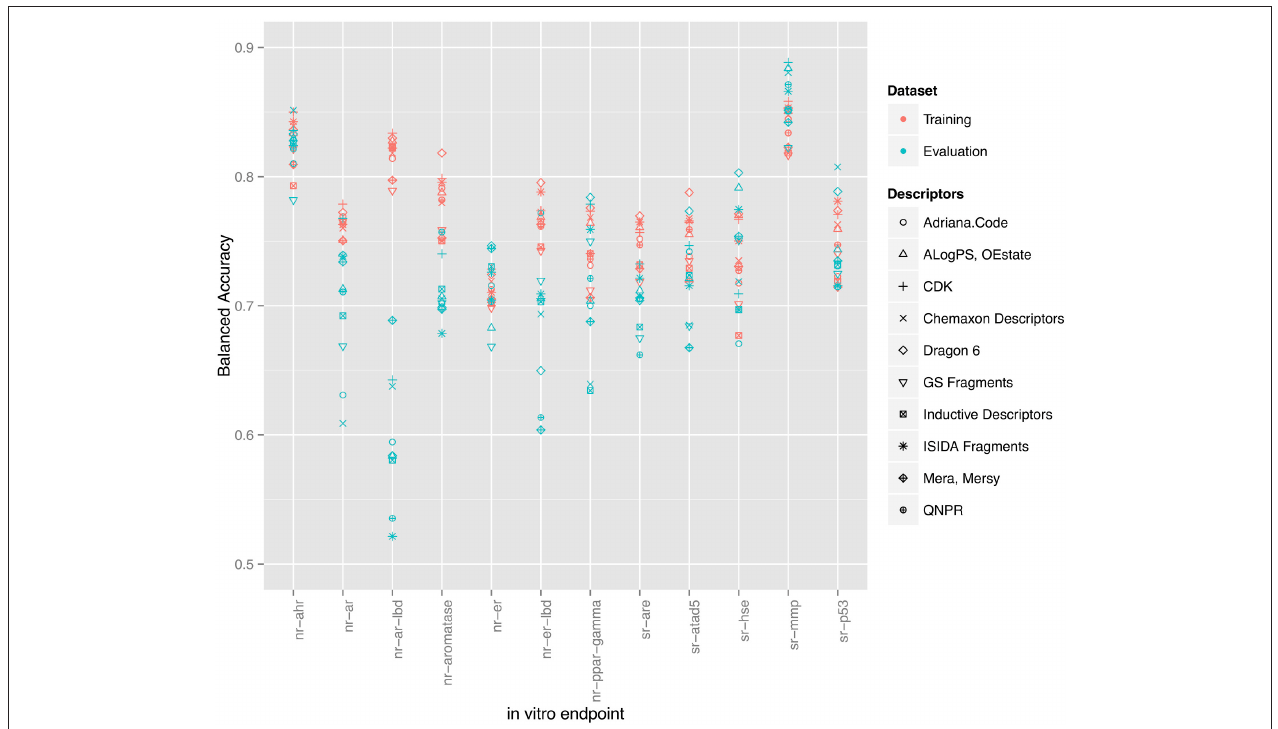
FIGURE 2 | Training set balanced accuracies for all 120 models as grouped by their respective endpoints. Red points represent the validated (through bagging) balanced accuracies calculated on the training set. Blue points represent the balanced accuracy on the evaluation set.